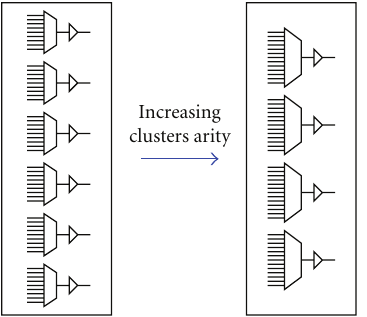
Figure 9: Varying clusters arity ⇒ varying multiplexers sizes and